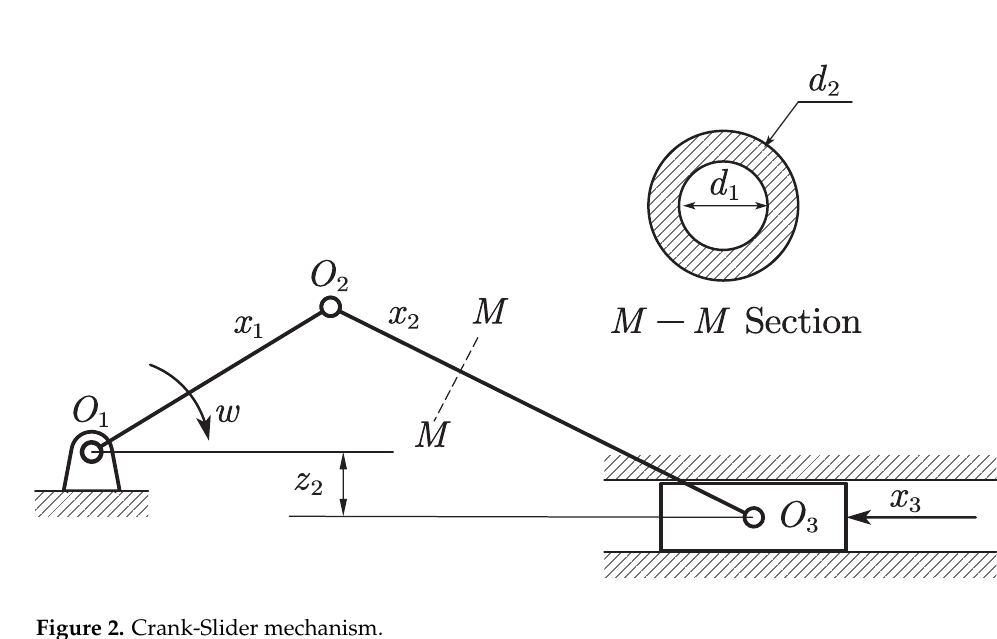
Figure 2. Crank-Slider mechanism. Table 1. Aleatoric uncertainty variables x .